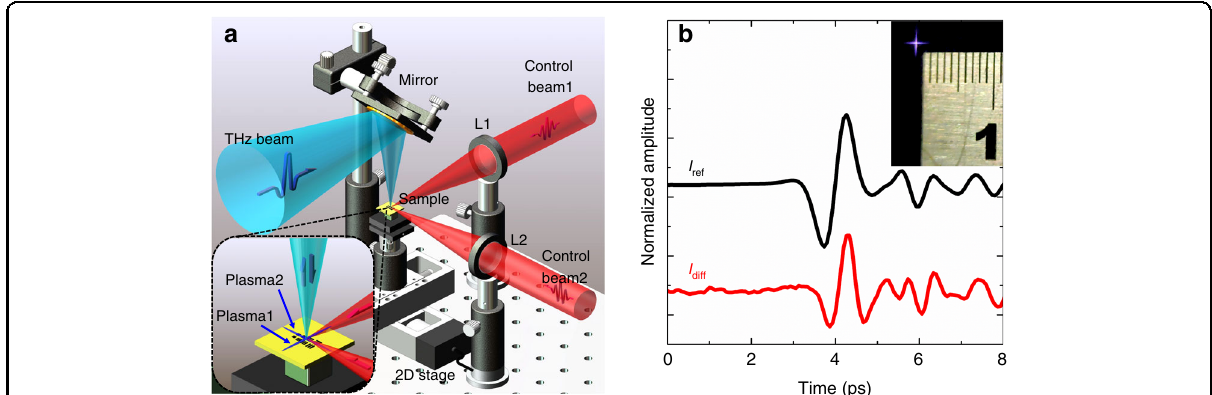
Fig. 1 Design concept. a Schematic of terahertz (THz) near- fi eld microscopy based on an air-plasma dynamic aperture. Two femtosecond laser pulses were focused in mutually perpendicular directions to generate two air-plasmas (Plasma1 and Plasma2) close to the sample surface. The incident THz beam was modulated by the cross- fi lament created by the air-plasmas and the re fl ected THz near- fi eld signal was measured. The inset shows the relationships between the two air-plasmas, the THz beam, and the sample. b Normalized reference ( I ref ) and near- fi eld ( I diff ) THz temporal signals re fl ected by a metallic plate. The inset shows the cross- fi lament and a